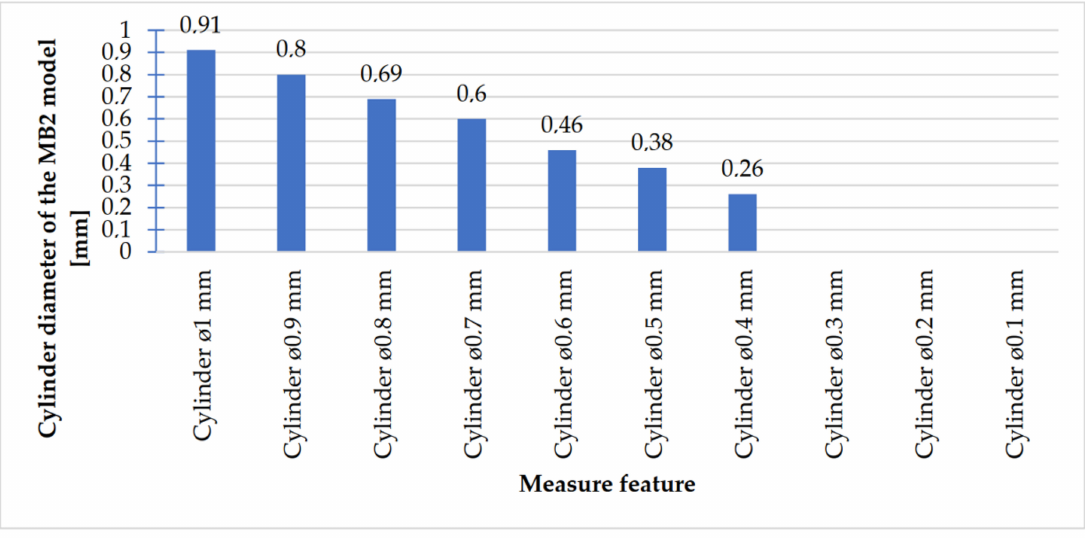
Figure 21. Average values calculated based on the cylinders measurement results with dimensions Ø1–Ø0.1